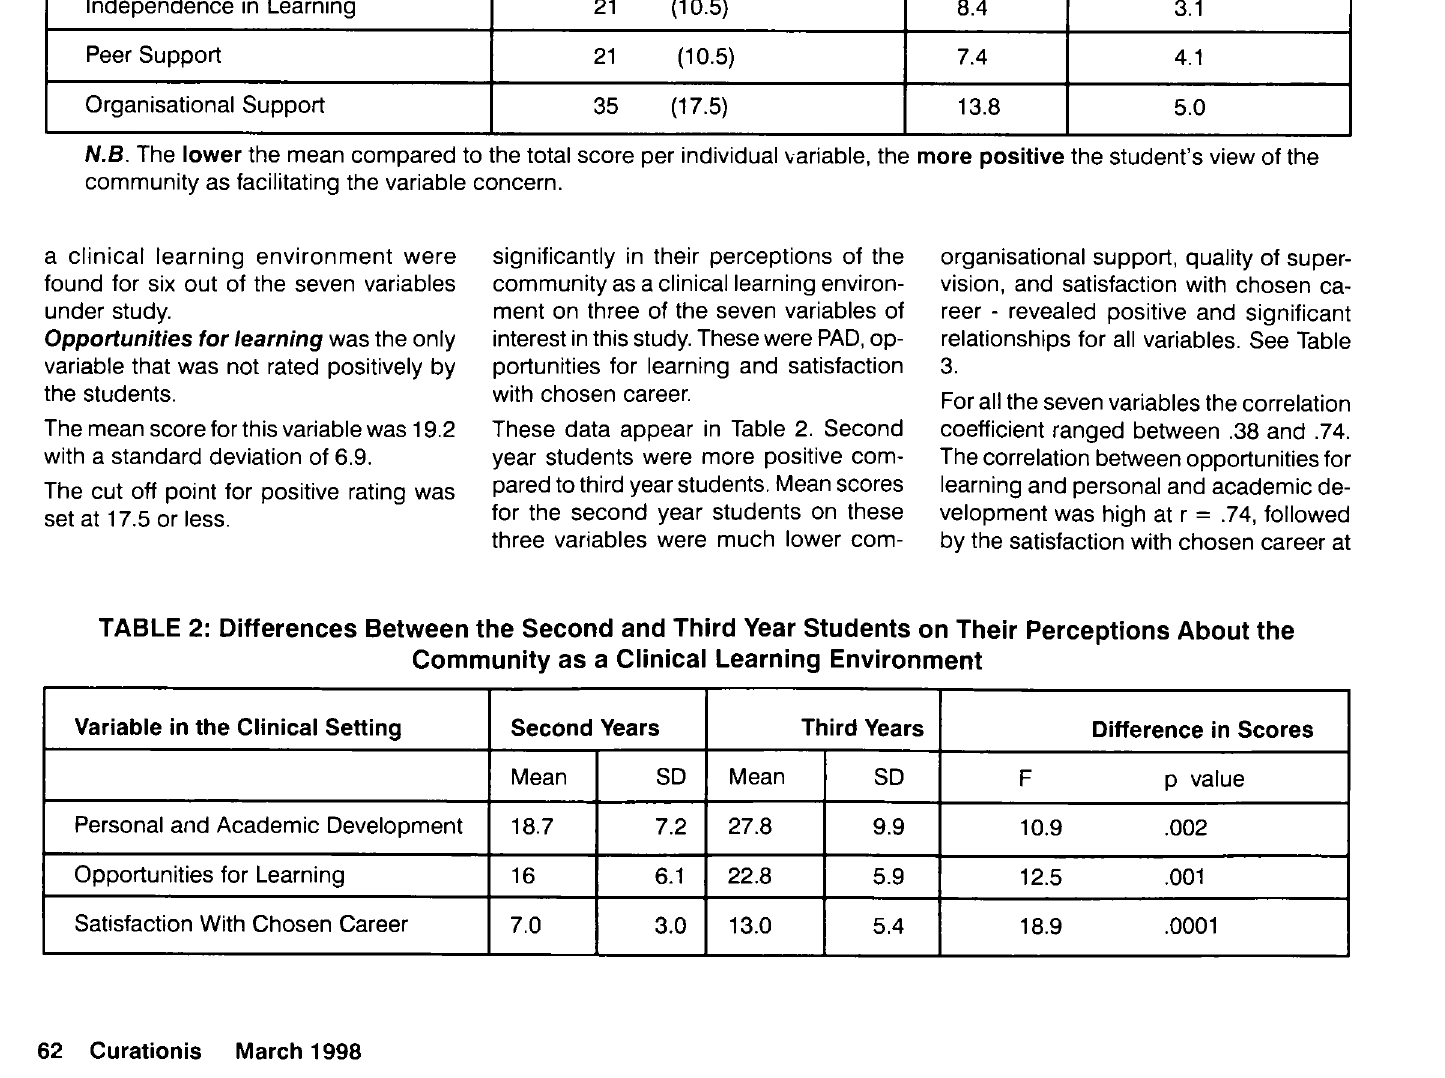
TABLE 2: Differences Between the Second and Third Year Students on Their Perceptions About